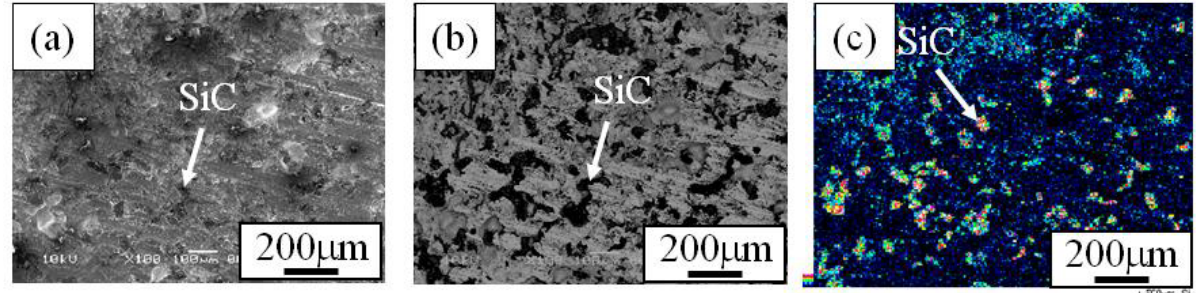
Figure 5. Microstructures on the surface of Specimens 2. (a) SE Image, (b) Compo Image and (c) Si distribution map by EDX [17].